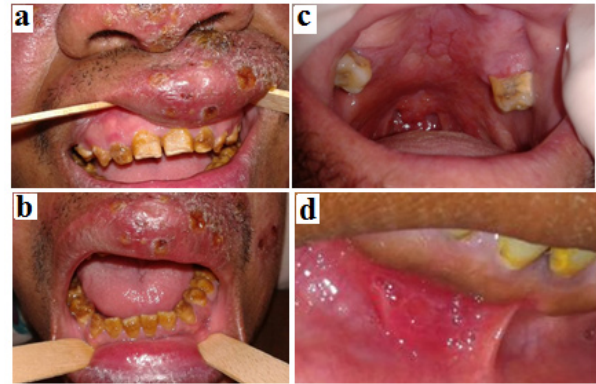
Figure 1. Oral examination evincing poor oral health status and amelogenesis imperfecta reported at Case-1 ( a and b ); Infiltrative lesion on hard, soft palate and uvula reported at Case-2 ( c ); Ulcerated lesions in the lower lip frenulum, reported at Case-3 ( d